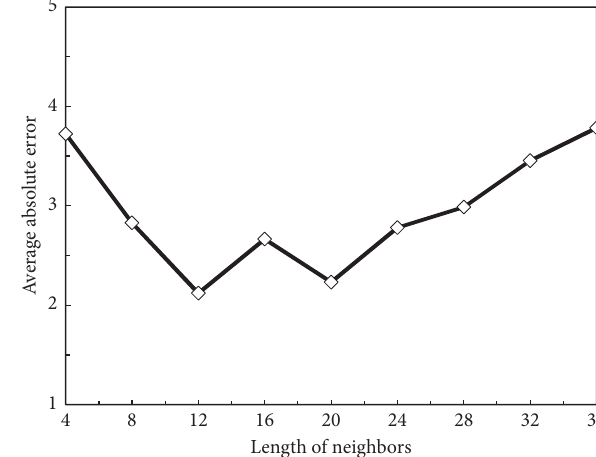
Figure 7: Average absolute error vs. length of neighbors.